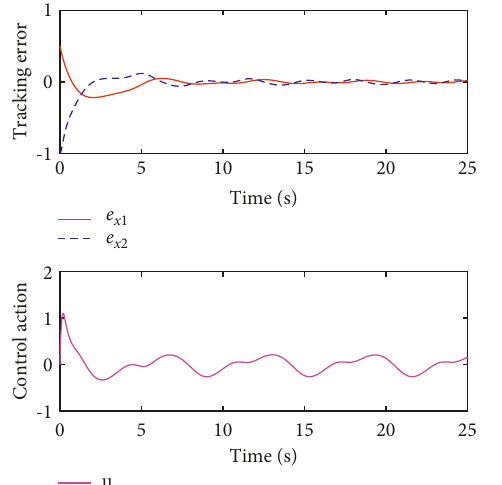
Figure 7: Tracking error and proposed control action with (34) (case 1).